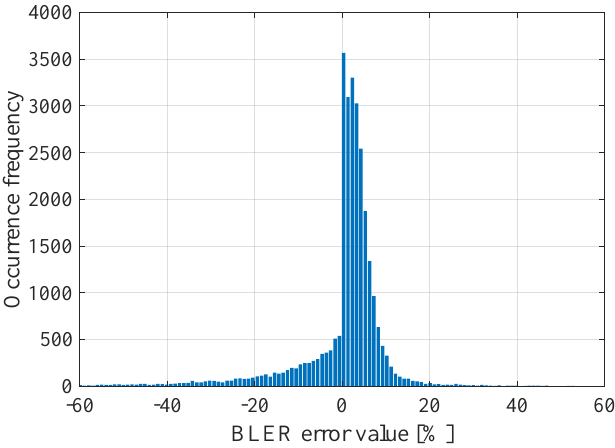
Figure 23. The BLER error histogram of the proposed DL